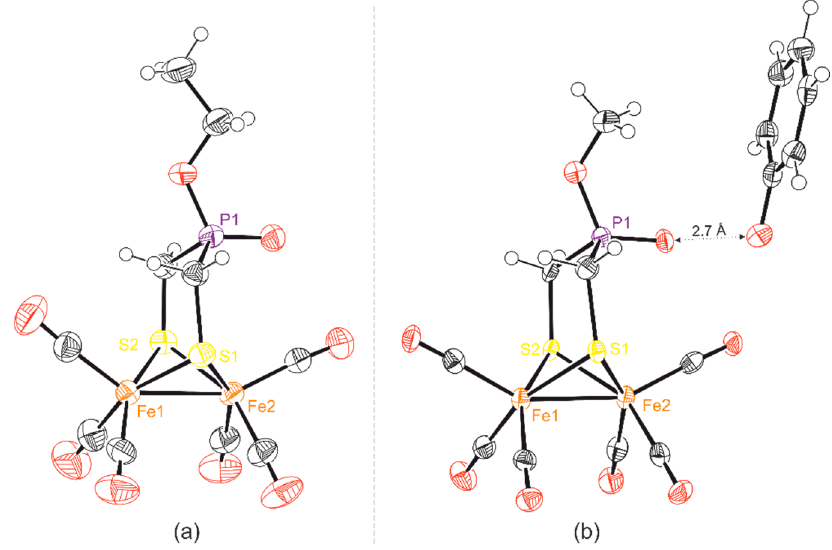
Figure 5. ( a ) OPTEP Plot of compound 12-OEt ; ( b ) ORTEP Plot of compound 12-OMe . Ellipsoids at 50% probability level. 12-OMe crystallizes in P-1, showing two individual moieties of the iron carbonyl and one phenol. Here, only the phenol-coordinating moiety is shown. For the complete asymmetric unit see Figure S1. Color code: black: carbon, white: hydrogen, red: oxygen, yellow: sulfur, purple: phosphorous.